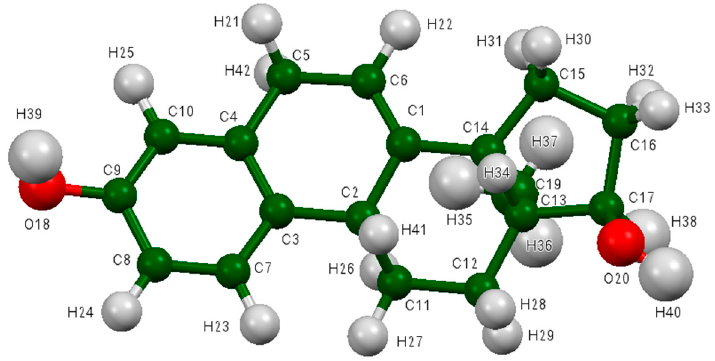
Figure 7. The asymmetric unit of 17 α -dihydroequilin, showing the atom numbering. The atoms are represented by 50% probability spheroids. C is shown in dark green, O in red, and H in light grey.